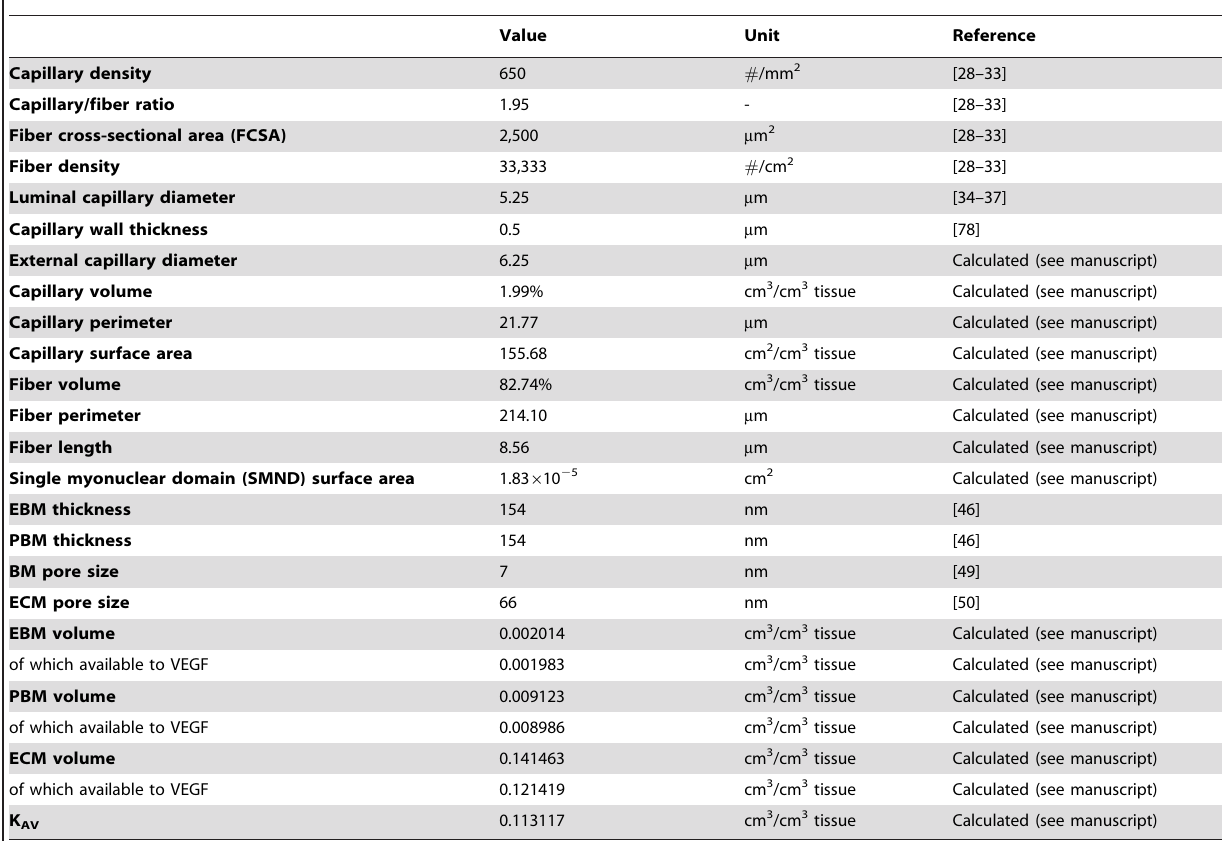
Table 2. Geometric parameters of mouse gastrocnemius